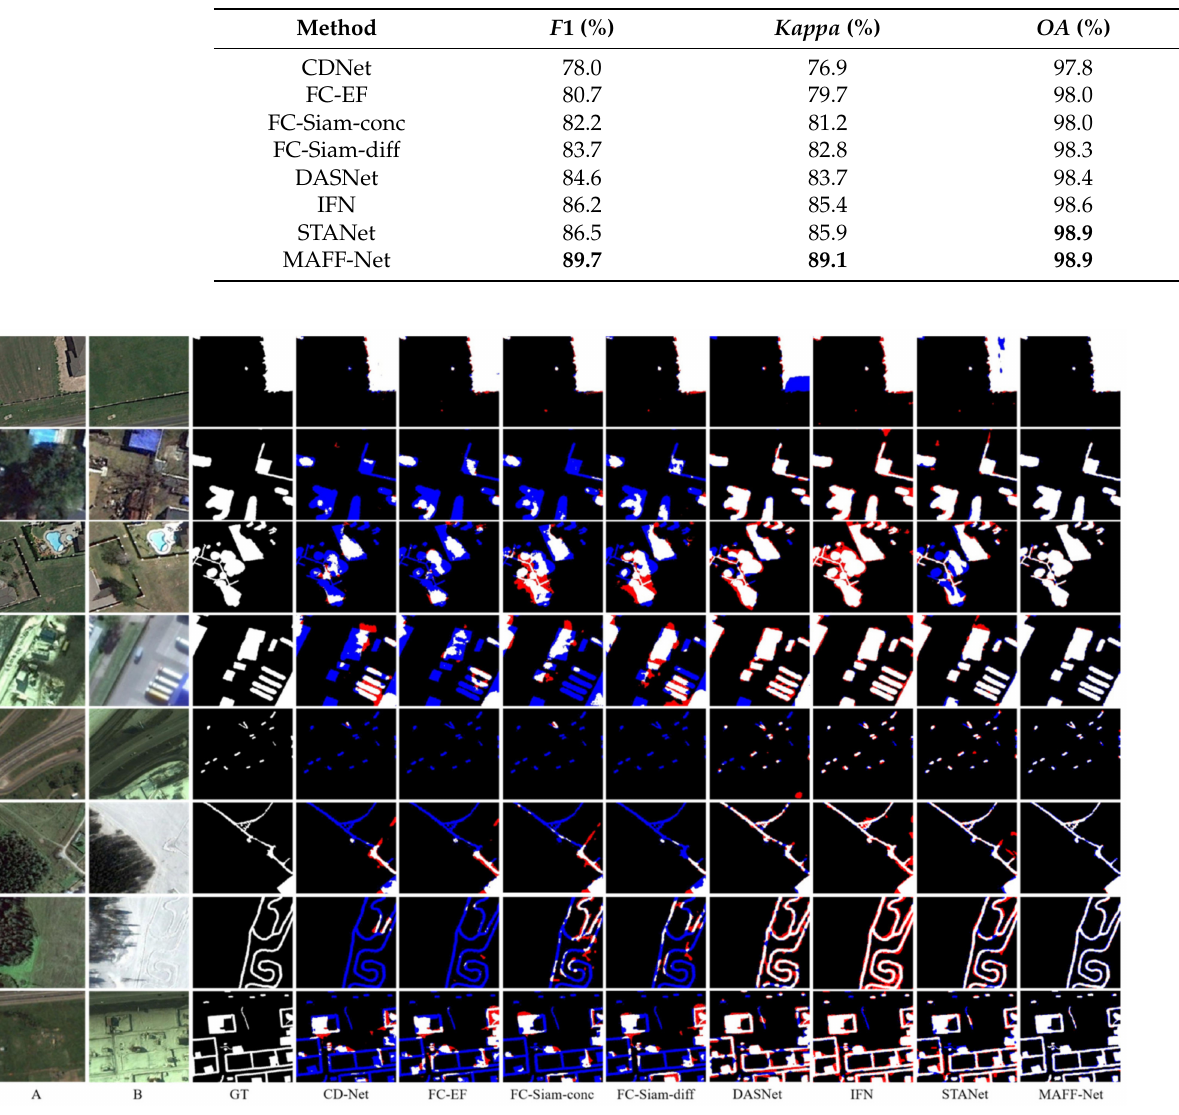
Table 3. Comparison of LEVIR-CD dataset results. The best scores are highlighted in bold.